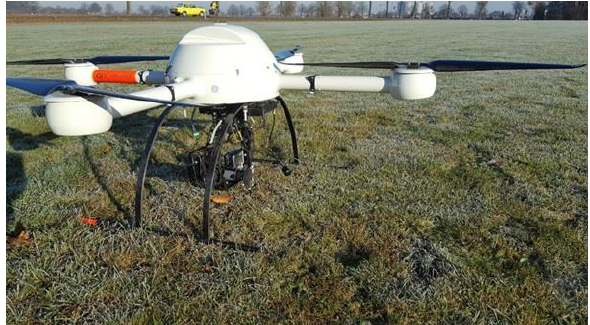
Figure 1. Md4-1000 from microdrones, equipped with thermal and RGB